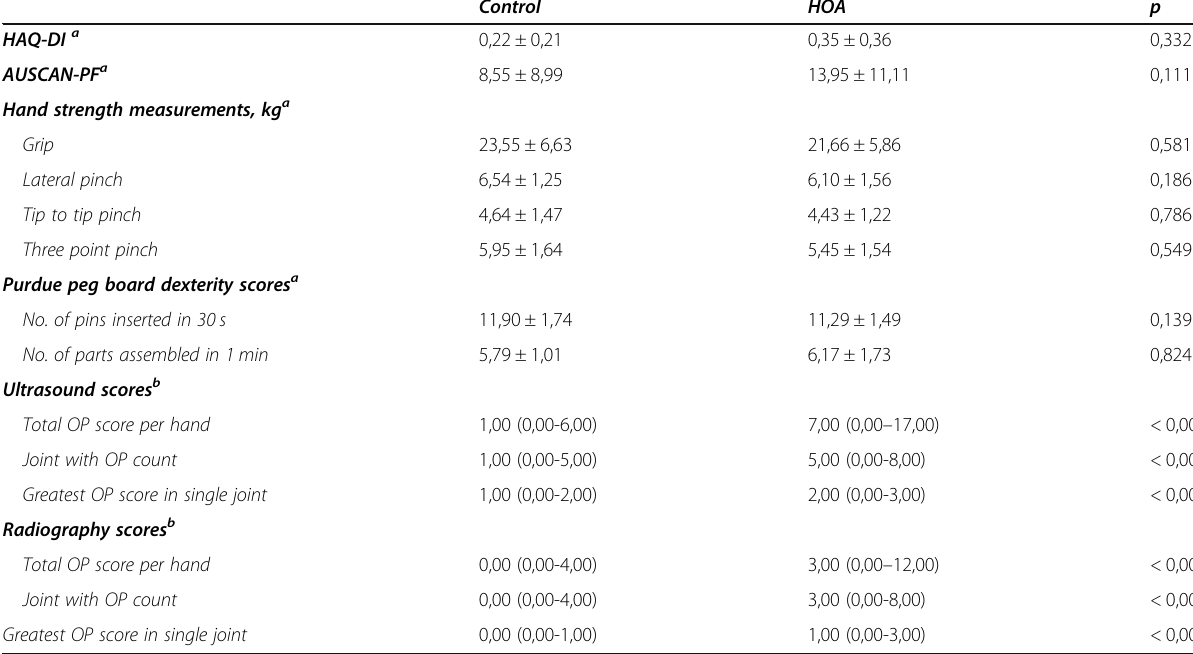
Table 3 Comparison of HAQ, strength, dexterity, radiography and ultrasound scores between groups Control